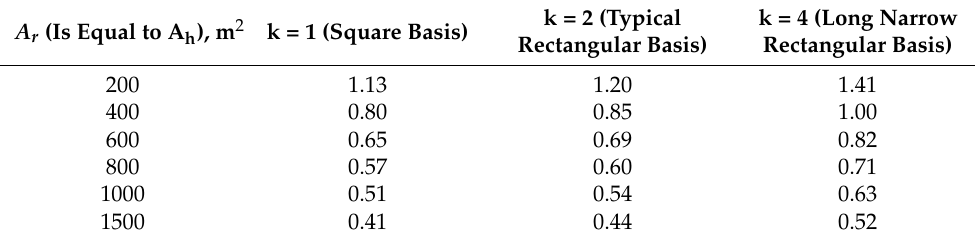
Table 1. Values of the ratio of outer walls area to roof area, AR , according to Equation (8) with typical value of h = 4 m for a single floor building ( n = 1).